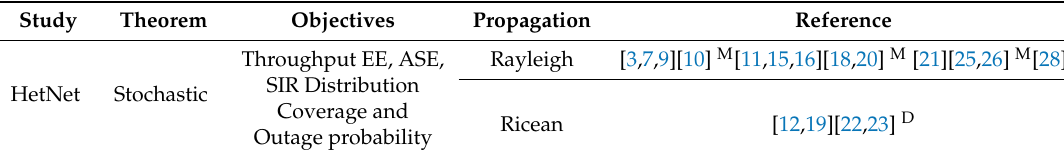
Table 1. Summary of Related